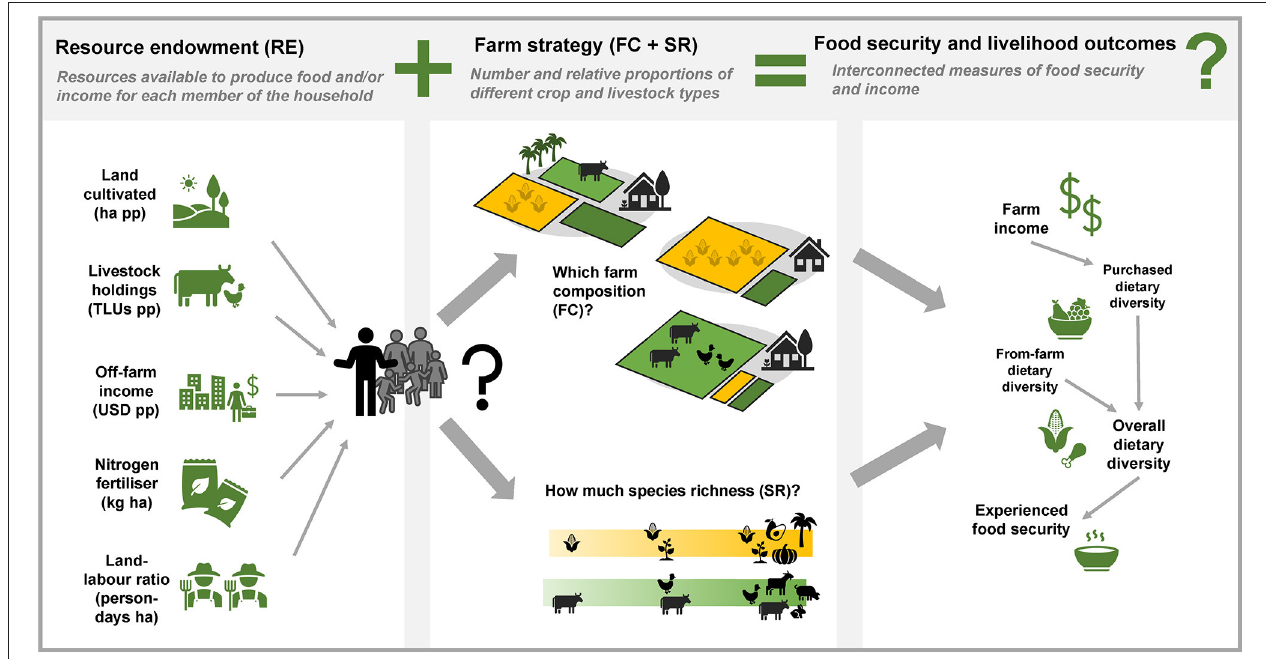
FIGURE 1 | A conceptual framework showing how the different variables considered in this study are related.